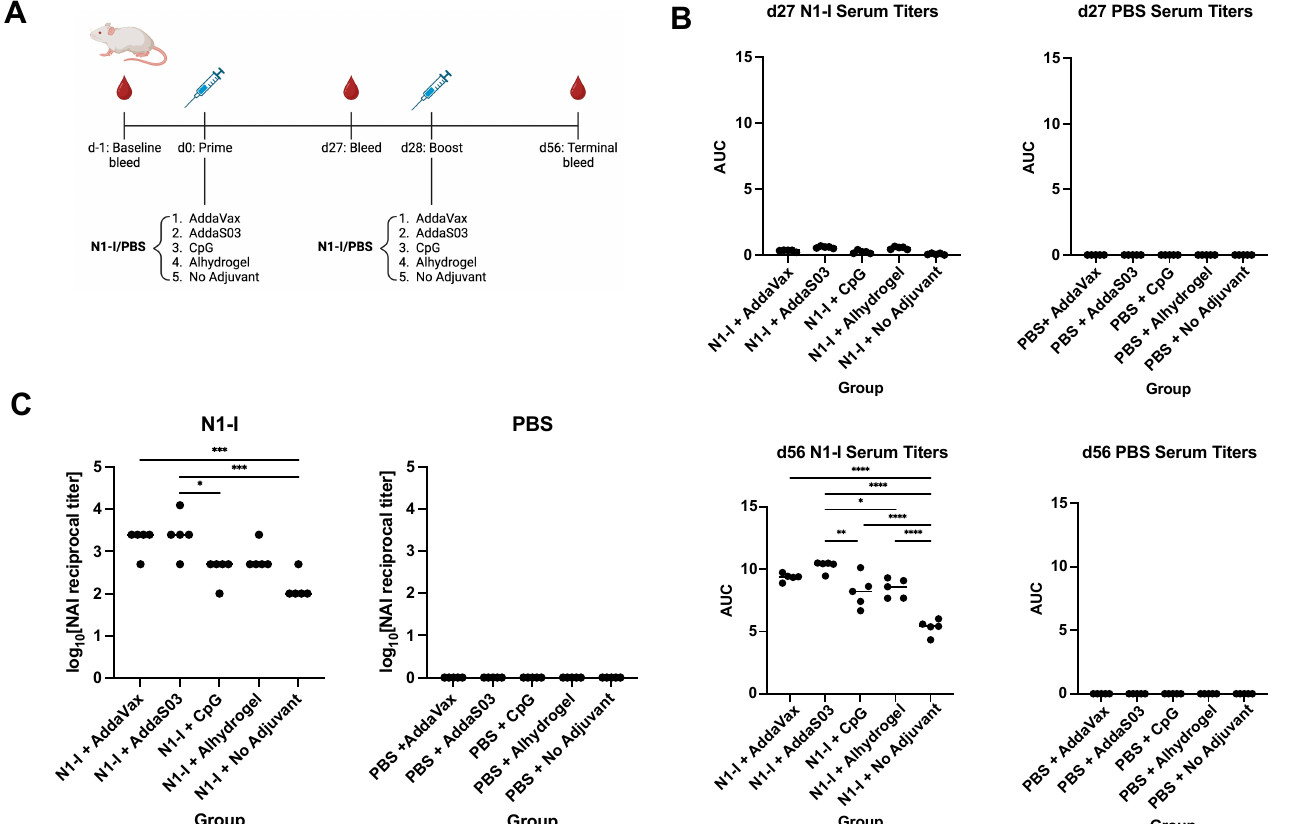
Figure 6. N1-I NA immunization schedule, serum IgG titers, and NAI titers after vaccination. ( A ) Immunization scheme of the N1-I NA study. ( B ) d27 and d56 serum IgG titers, determined by ELISA, against the N1-I NA COBRA. Titers are shown as AUC. ( C ) Terminal NAI titers after vaccination against A/CA/09, shown as log 10 -transformed reciprocal dilutions. NAI titers were determined as the serum dilution that provided 50% inhibition of NA activity. A minimum baseline absorbance at 405 nm of 0.3 was considered a positive binding signal. *, p ≤ 0.05; **, p ≤ 0.01; ***, p ≤ 0.001; ****, p ≤ 0.0001. One-way ANOVA was used for statistical comparisons between groups. NAI assays were performed to assess the functionality of serum antibodies following N1-I vaccination against the A/CA/09 virus (Figure 6C). We found that NAI titers were highest for AddaS03 and AddaVax, followed by Alhydrogel and CpG. Again, these trends are similar to those seen in ELISAs. These results imply that serum antibodies elicited by N1-I are functional and can decrease NA enzymatic activity. Oil-in-water emulsion adjuvants appeared to be more effective than CpG or Alhydrogel in inducing these NA- inhibitory